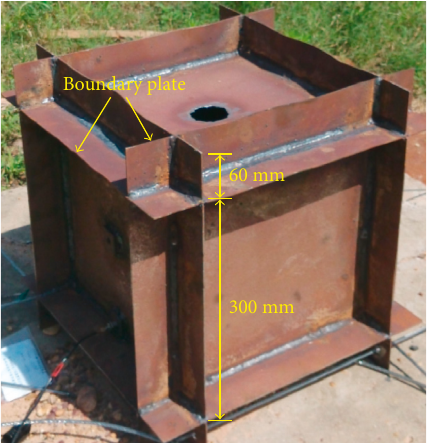
Figure 1: Steel box